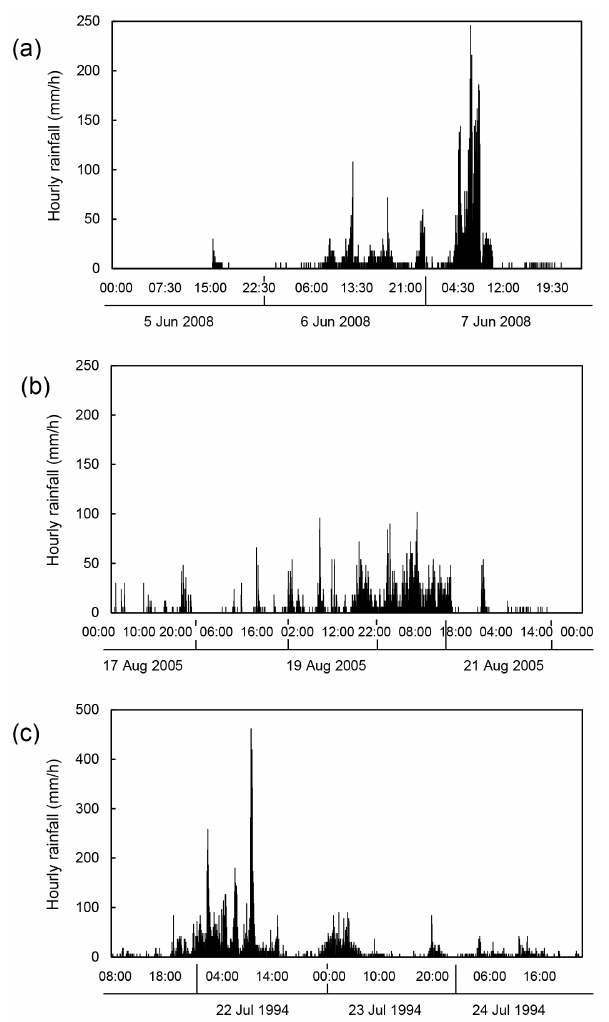
Figure 6. Hyetographs of three storms: (a) 5–7 June 2008 storm, Station N19; (b) 17–21 August 2005 storm, Station N01; (c) 22– 24 July 1994 storm, Station N14.